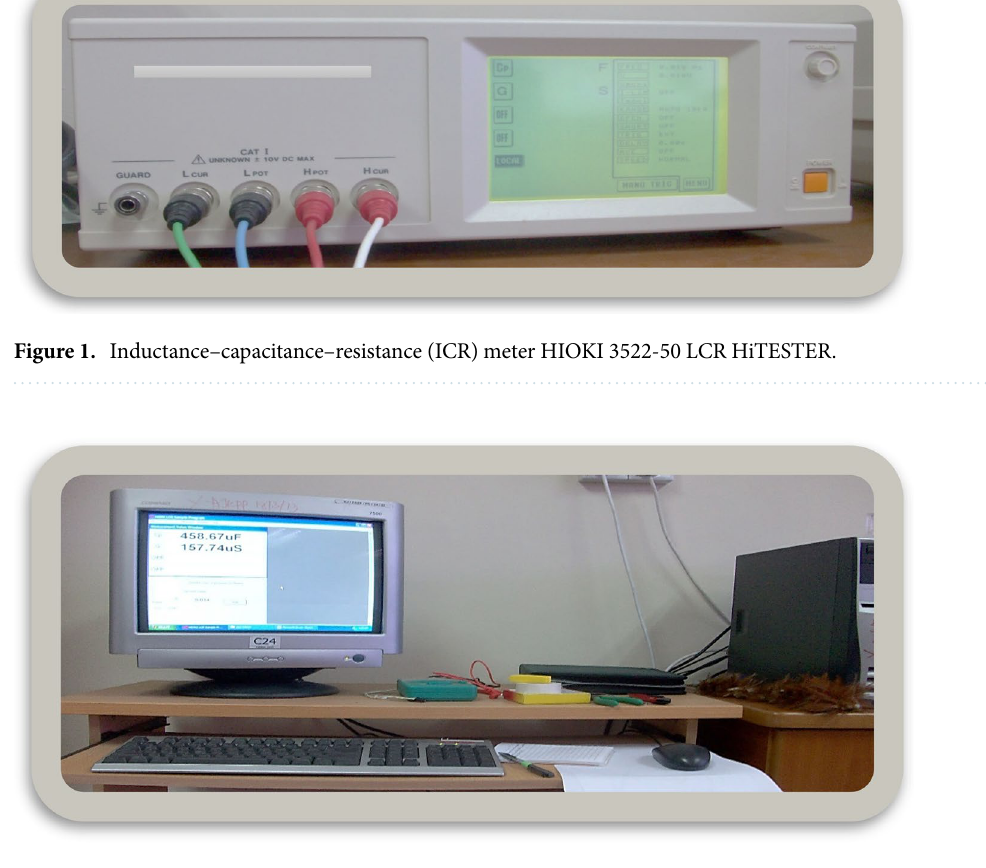
Figure 2. Monitor that received the data during